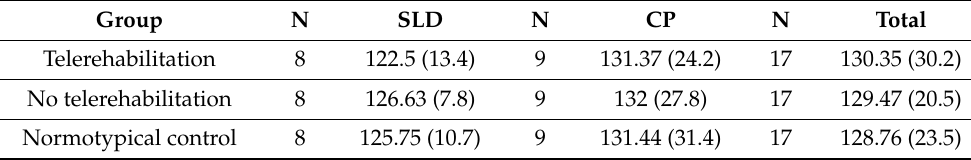
Table 1. Mean age and SD (in parentheses) of the three groups by diagnosis. Group N SLD N CP N Total